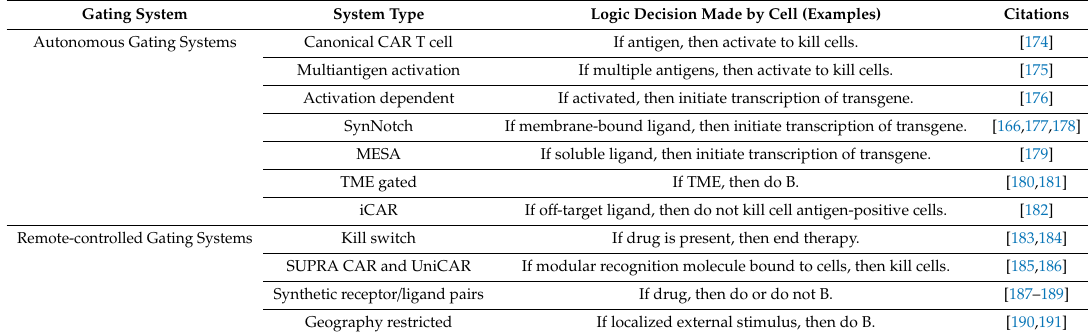
Table 3. Gated “smart” synthetic cell